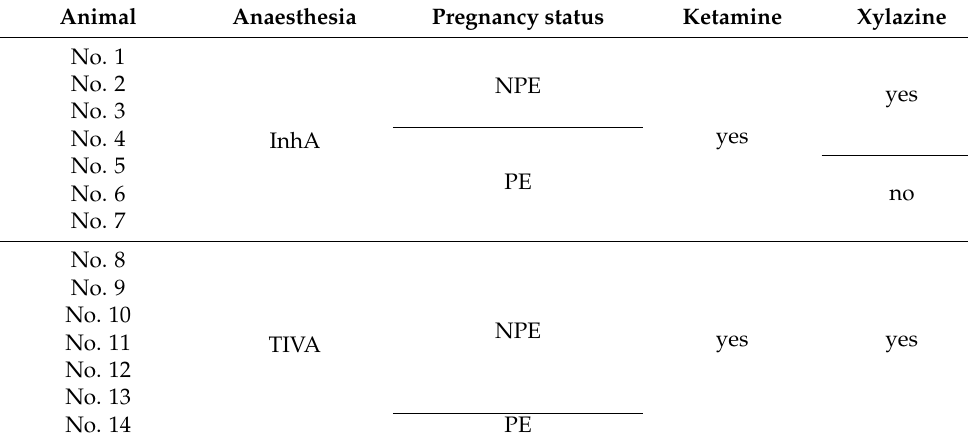
Table 1. Overview on anaesthesia in operated